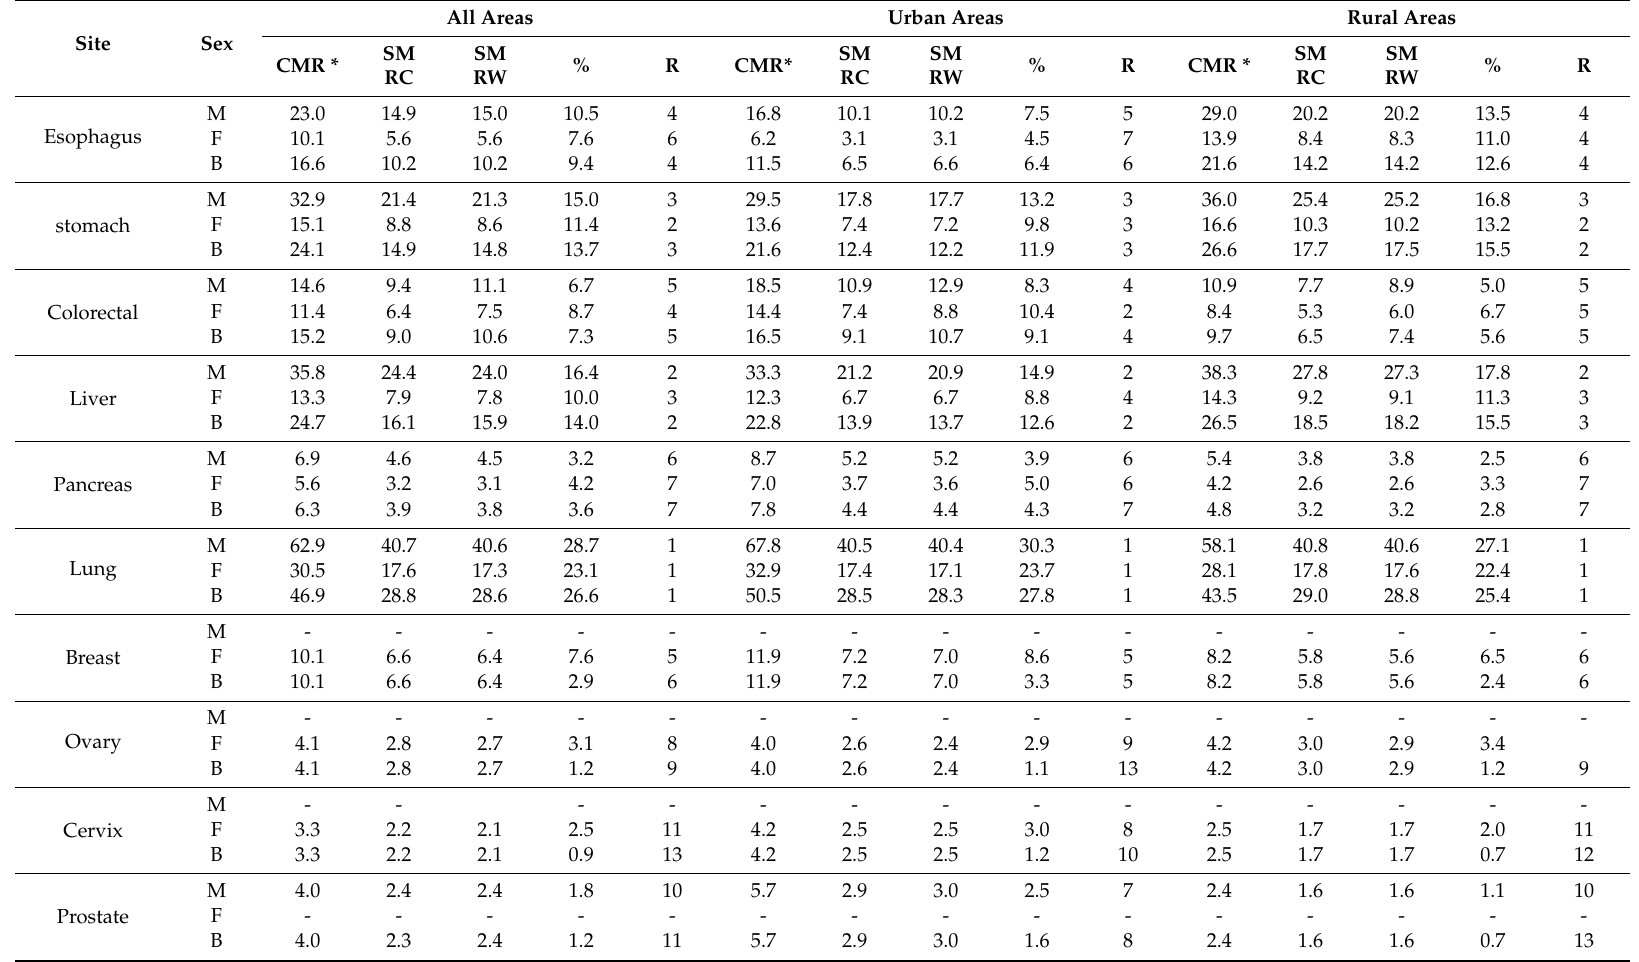
Table 1. Mortality and ranks of cancers in China, 2013( / 10 5